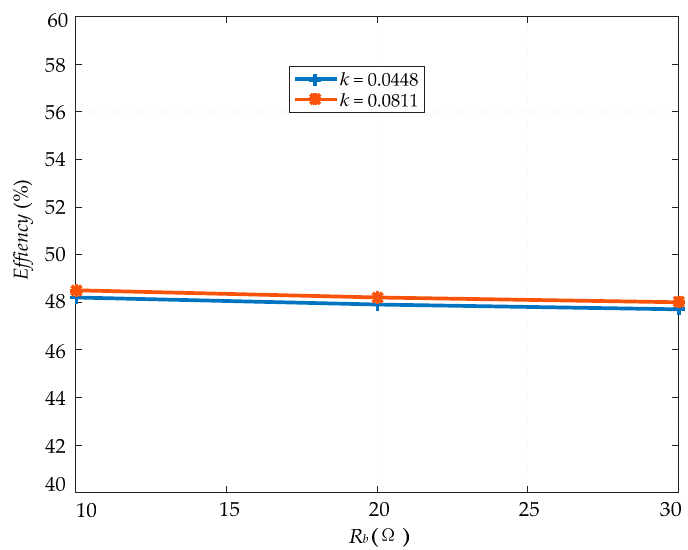
Figure 9. Simulation analysis of system efficiencies under maximum power transfer tracking (MPTT) condition.